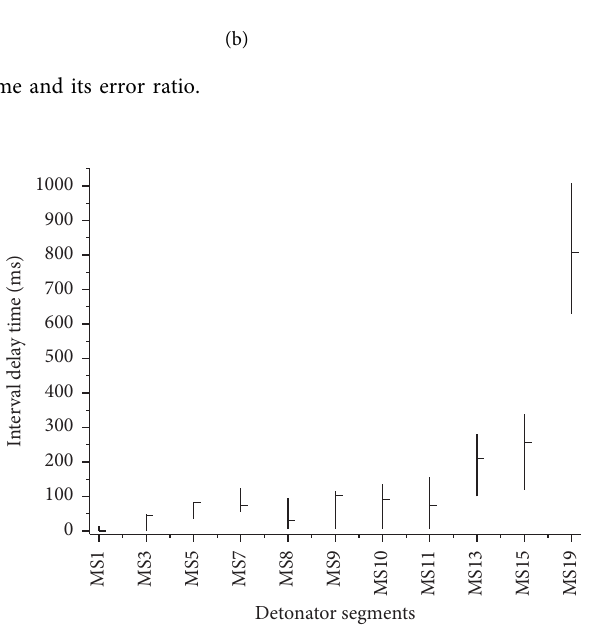
Figure 6: Initiation time and monitored time interval of detonators.